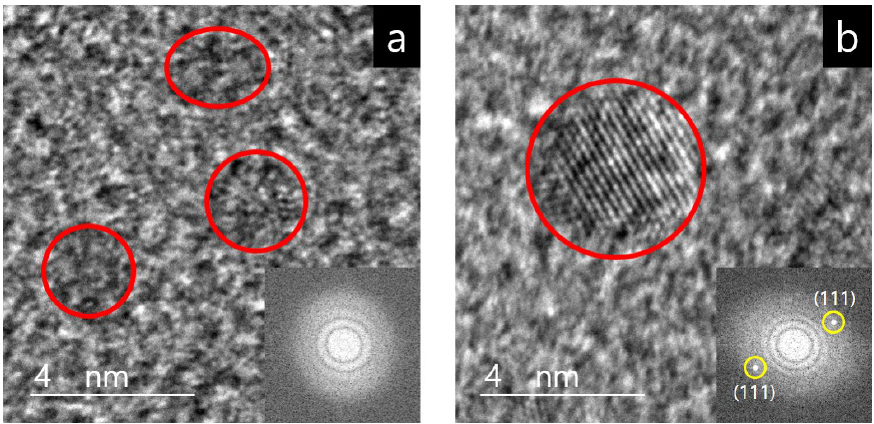
Figure 2. TEM images of Ag particles captured on an amorphous carbon membrane at the substrate bias of 0 V for ( a ) 1 s, ( b ) 3 s, ( c ) 5 s, ( d ) 7 s and ( e ) 10 s.